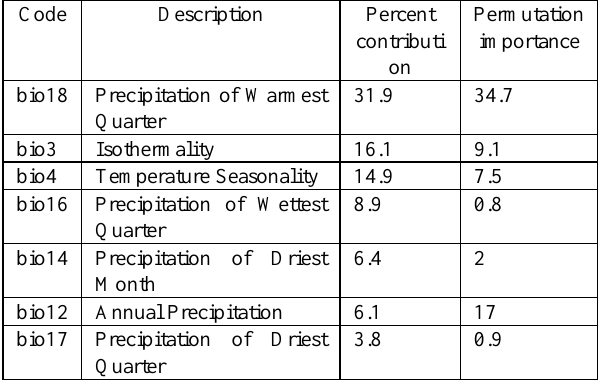
Table 1. Environmental variables used for modeling of June to October data and its percent contribution & permutation importance